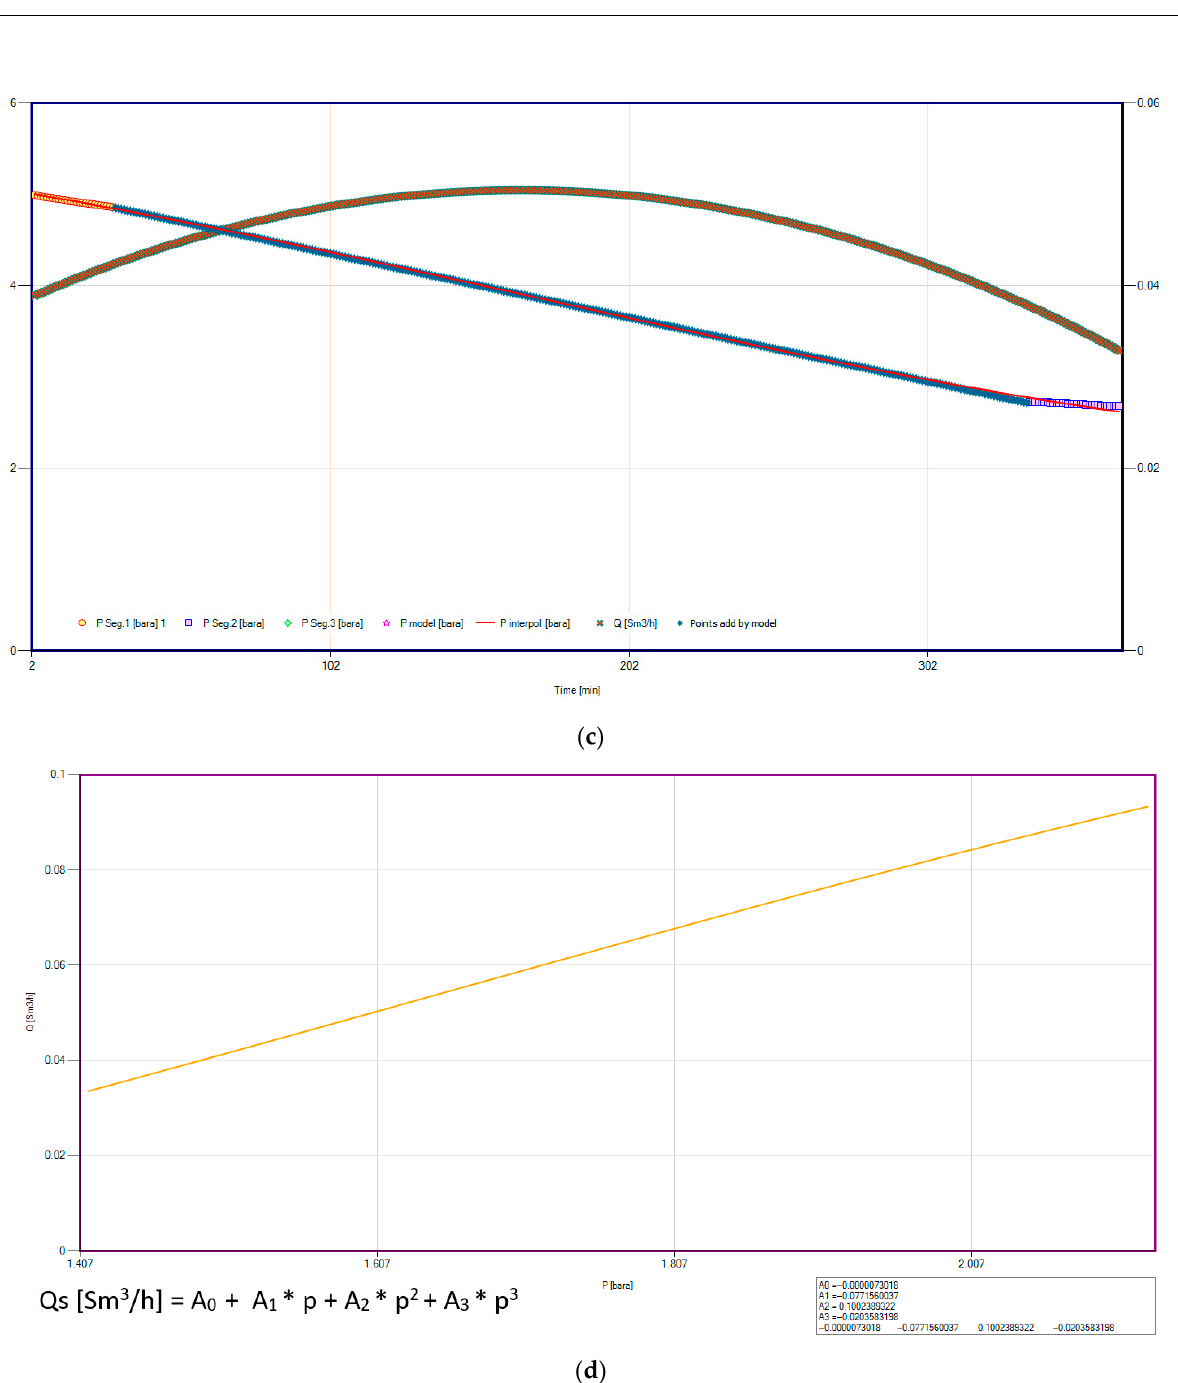
Figure 6. Data processing stages: ( a ) experimental data for 1 in and 3 turns ill-fitting; ( b , c ) curves modelled for pressure and calculated flow; ( d ) flow—pressure variation for 1 in and 3 turns—adjusted pressure (source: authors based on the analysed data).